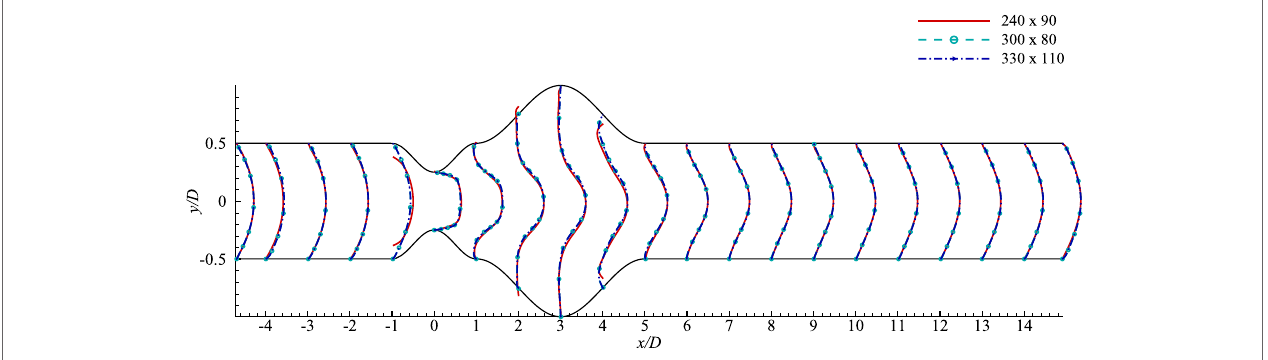
FIGURE 3 | Grid resolution test with respect to streamwise velocity at various axial locations, i.e., x / D = inlet, x / D = (cid:0) 4.0, x / D = (cid:0) 3.0, x / D = (cid:0) 2.0, x / D = (cid:0) 1.0, x / D = 0.0, x / D = 1.0, x / D = 2.0, x / D = 3.0, x / D = 4.0, x / D = 5.0, ... , x / D = 14 outlet based on three grid combinations, Case 1: solid line for 240 (cid:2) 90 control volumes, Case 2: dashed line for 330 (cid:2) 110 control volumes considering stenosis = 60% constricted and aneurysm = 100% dilated for Re =